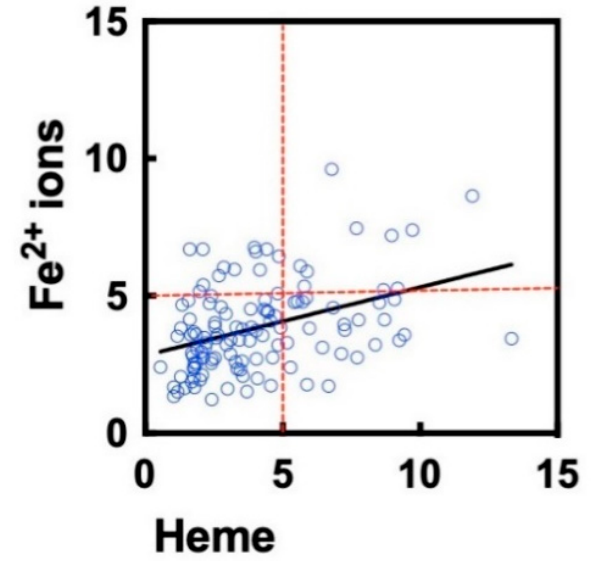
Figure 3. Correlation of heme- and ferrous ion-induced polyreactivity of clinical-stage Abs. The graph depicts the correlation (Spearman analyses) of the fold increase in the antigen-binding intensity (averaged gain in reactivity for three unrelated proteins) after treatment of Abs with heme or ferrous ions. The reactivity of each Ab is presented as an individual circle. The correlation was characterized by Spearman coefficient ρ = 0.38 and p < 0.0001. The data for heme-treated Abs were taken from a previously published study [23] .